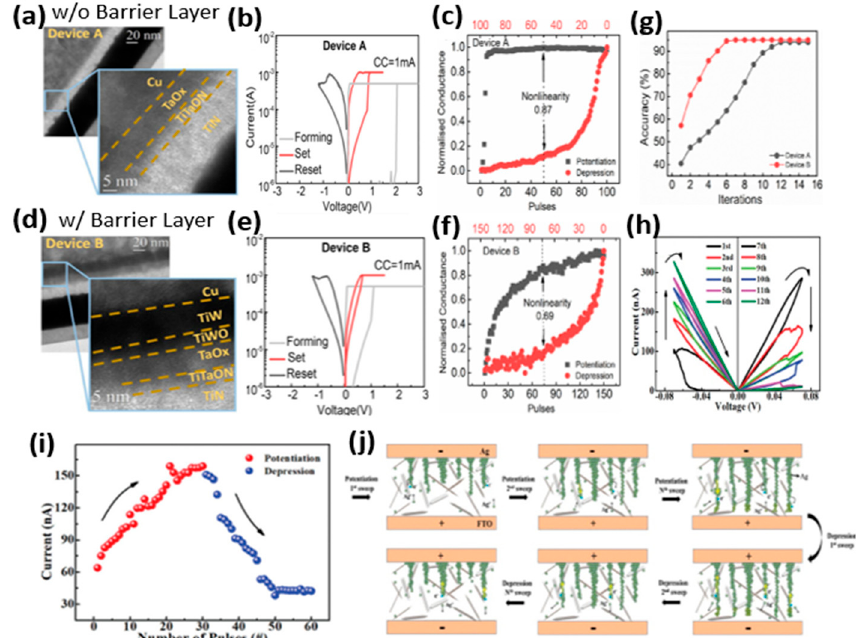
Figure 12. Analog switching in CBRAM for the synaptic emulation. ( a ) The cross-sectional TEM image of a CBRAM device fabricated without a barrier layer and ( b ) its corresponding I–V characteristics showing an abrupt switching behavior and ( c ) the LTP/LTD characteristics with a larger nonlinearity. ( d ) The cross-sectional TEM image of the engineered CBRAM device fabricated with a TiW barrier layer at the AE interface and ( e ) its corresponding I–V characteristics showing a gradual switching behavior and ( f ) the LTP/LTD characteristics with an improved nonlinearity. ( g ) Neural network training accuracy for devices with and without a barrier layer. Reprinted from Ref. [80]. ( h ) The I–V characteristics of an Ag nanoparticles-doped CNC-based CBRAM device showing analog switching and ( i ) its LTP/LTD characteristics. ( j ) The schematic illustration of the analog switching mechanism. Reprinted from Ref.